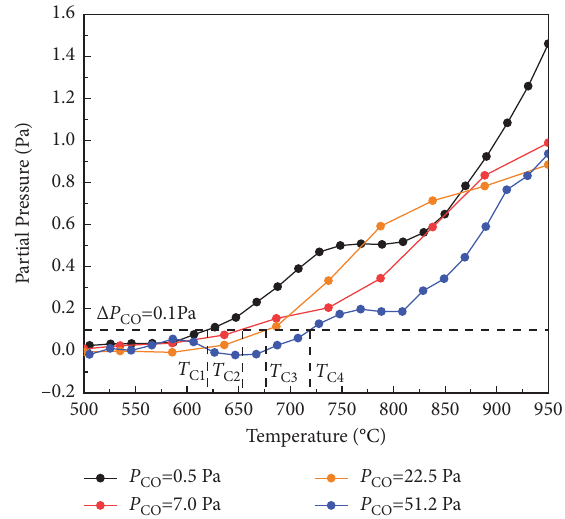
Figure 7: Evolution of the CO as a function of temperature during the heating